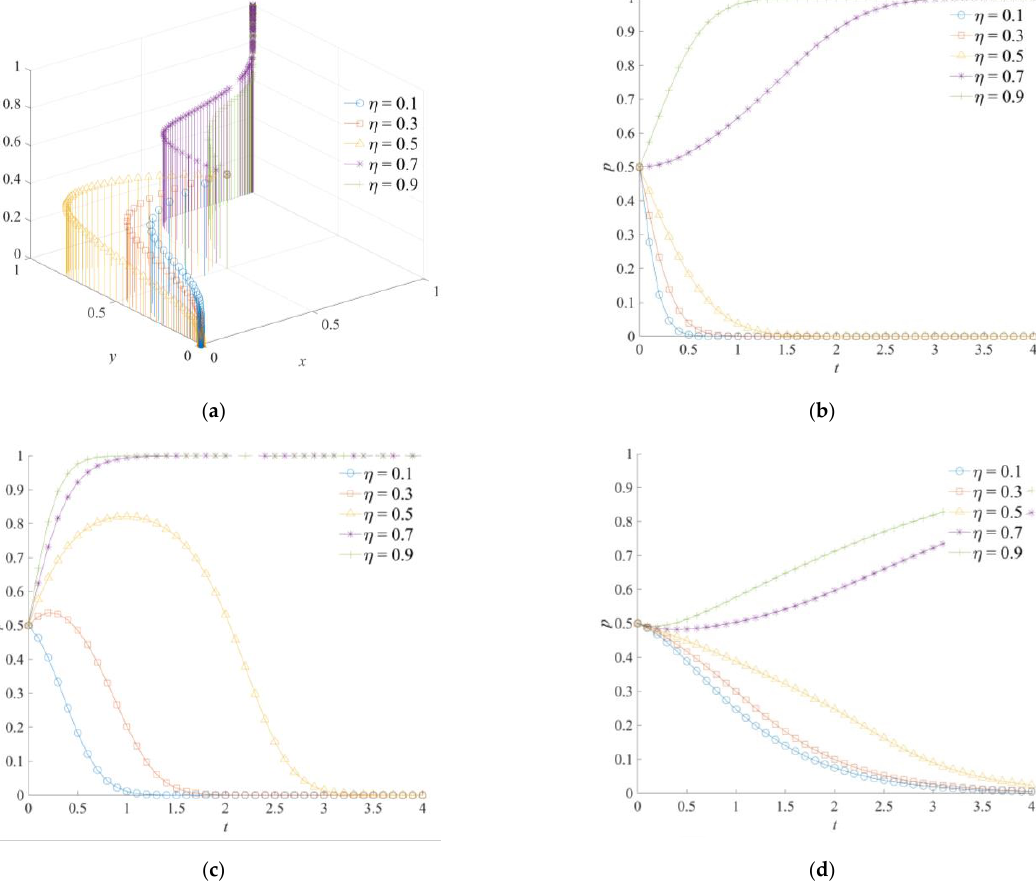
Figure 8. Evolution trajectory of the game system under different matching degrees of cross-regional emergency rescue: ( a ) The influence of η on the evolution of the game system; ( b ) the influence of η on the evolution of the local government; ( c ) the influence of η on the evolution of the neighboring government; ( d ) the influence of η on the evolution of the central government.